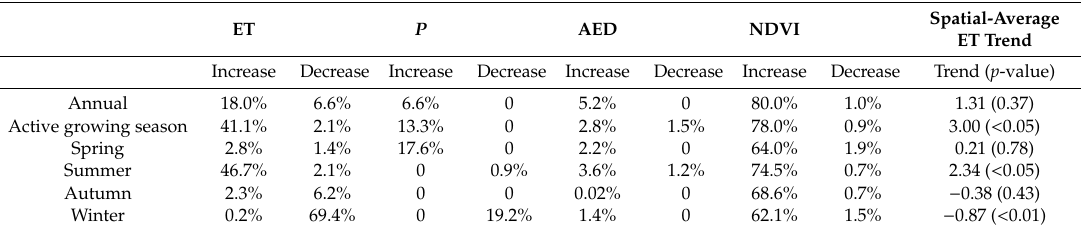
Table 2. Proportions of areas with interannual trends significantly increased or decreased in ET, P , AED, and NDVI ( p -value < 0.05), and spatial-average ET trends (mm yr − 1 ) for di ff erent timescales across the CLP region during 2000–2014.